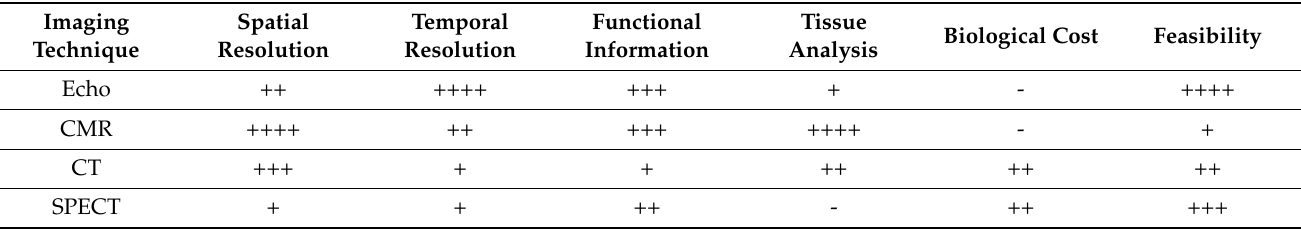
Table 1. Strength sand limitations of different cardiac imaging